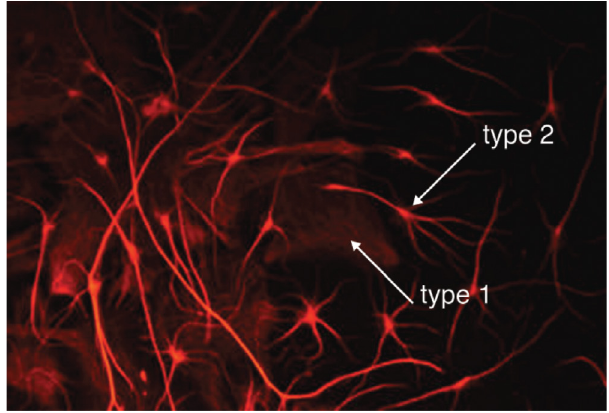
Figure 7. Histone H1 promotes the differentiation of astrocytes. Histone H1 applied for 24 hrs at 50 nM on 6-day cultured cortical astrocytes (visualized using antibodies to GFAP) promoted differentiation of stellate (type 2) over flat (type 1)